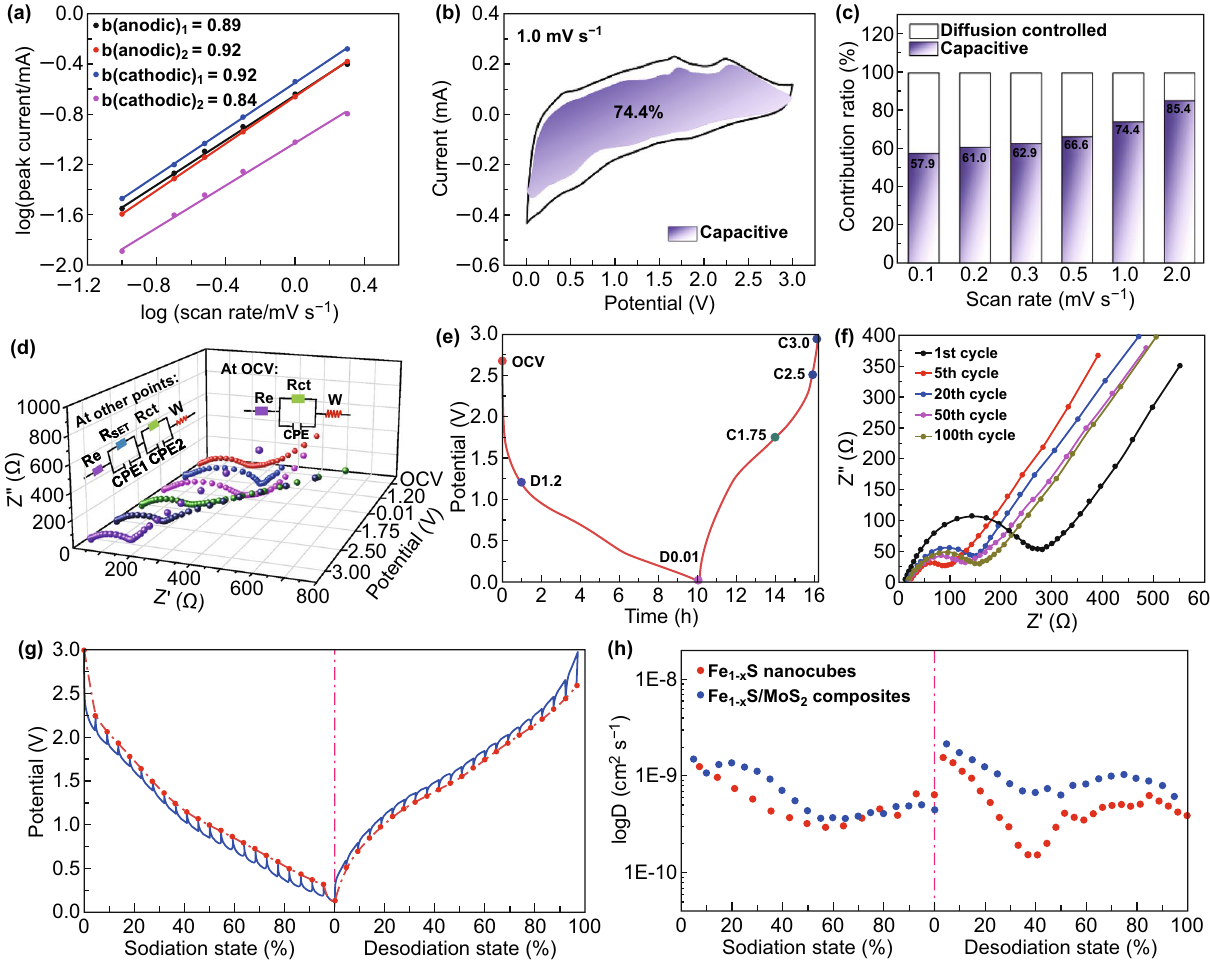
Fig. 3 Kinetic analysis of sodium storage behavior for Fe 1− x S/MoS 2 composite. a Linear relationship between log ( i ) and log ( v ). b Capacitive and diffusion-controlled contribution at 1.0 mV s −1 . c Normalized contribution ratio of capacitive capacities at different scan rates. d In situ EIS spectra evolution at different charge/discharge potentials. e First charge/discharge profile at 100 mA g −1 with labeled points for EIS. f EIS spectra after different cycles. g GITT curve. h The corresponding Na + diffusion coefficient at different discharge/charge state of Fe 1− x S/MoS 2 composite and pure Fe 1− x S